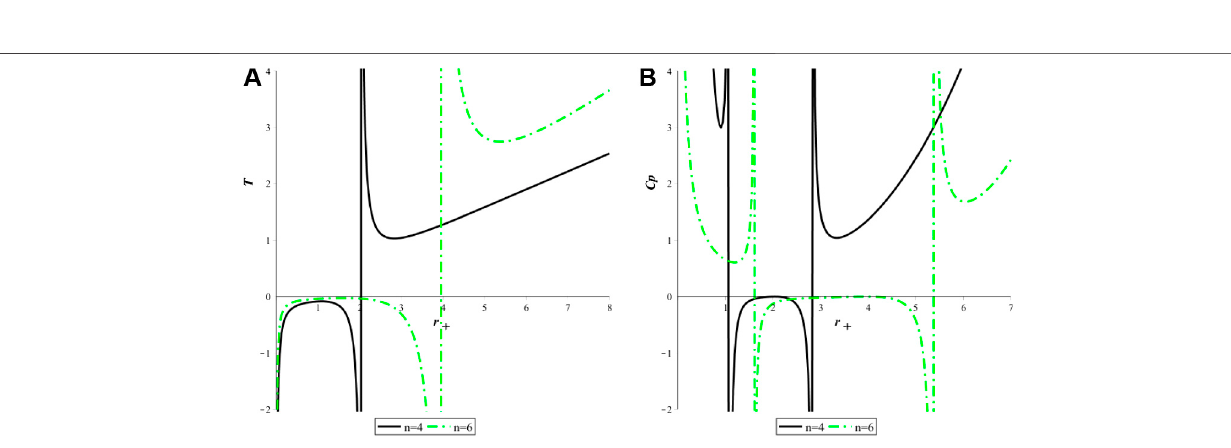
FIGURE 2 | Thermal stability of the BI quasitopological black hole with respect to r + for different values of dimension n with (cid:5) μ 2 (cid:1) 0 . 2, (cid:5) μ 3 (cid:1) 0 . 1, (cid:5) μ 4 (cid:1) − 0 . 001 k (cid:1) 1, q (cid:1) 1 and β (cid:1) 6 (A) Temperature T , (B) Heat capacity C P .